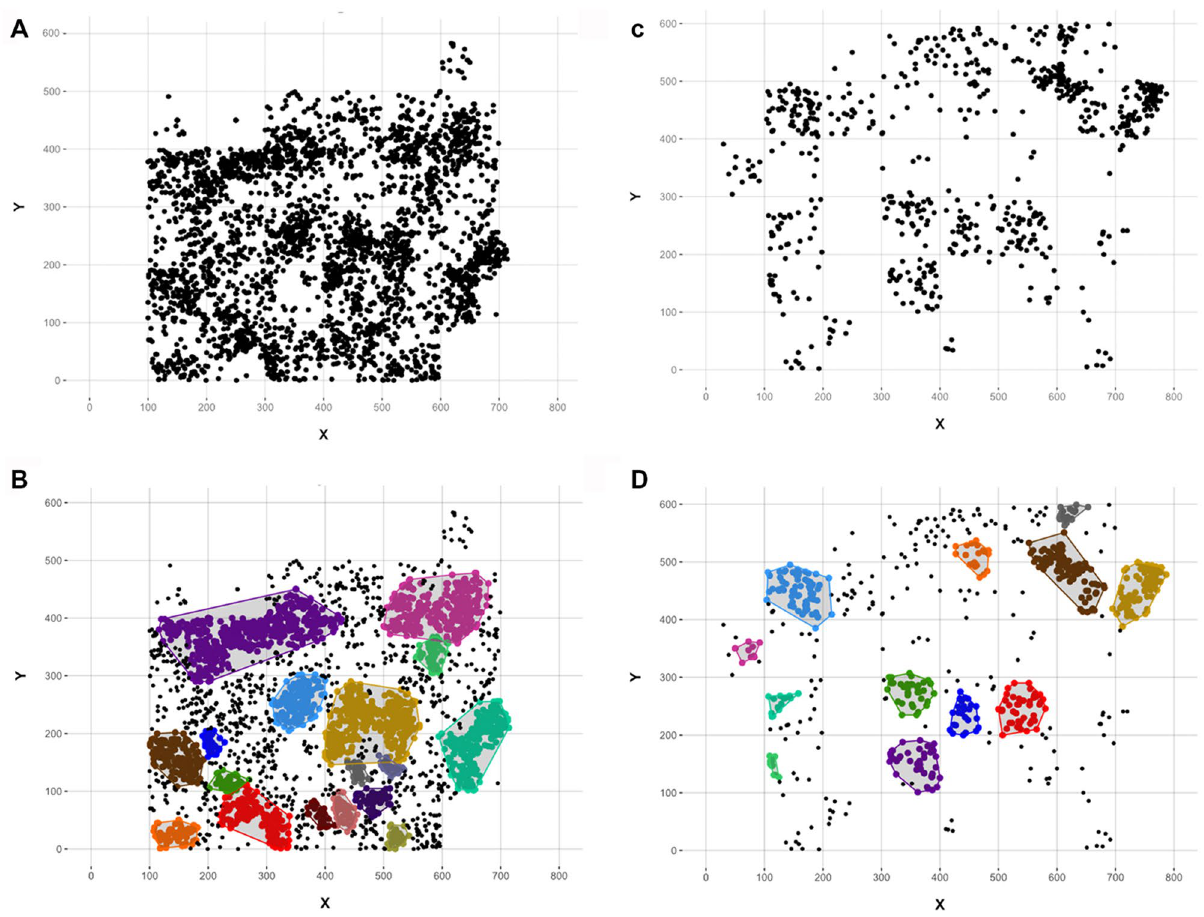
L the inhomogeneous variants of these tests were